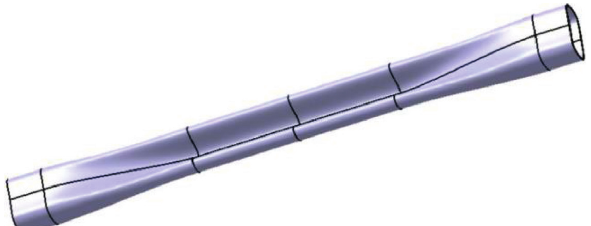
Figure 1: Original mathematical model diagram of the torsion